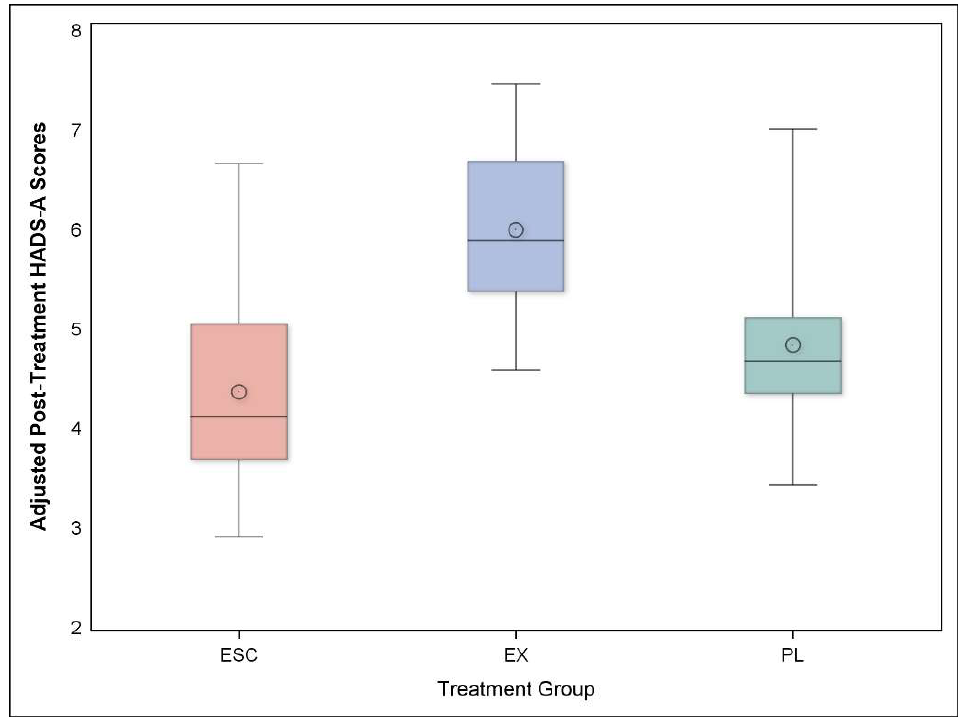
Figure 1. Comparison of scores on the HADS-A by treatment group at one year. Adjusted HADS-A anxiety scores at 1-year follow-up revealed that participants in the Escitalopram condition (ESC) had lower scores compared to Exercise (EX) ( P = 0.006). Multiple regression analyses were used with 1-year HADS-A scores serving as the outcome variable controlling for the pre-treatment HADS-A score, age, sex, race, baseline diagnosis of anxiety disorder, history of myocardial infarction, and treatment group as the predictor of interest.